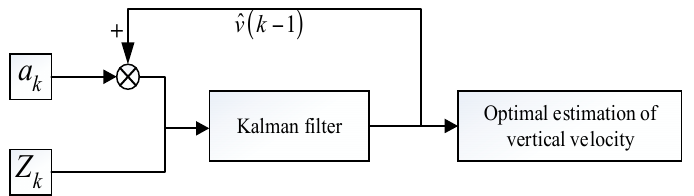
Figure 3. State function of the discretized fusion of the vertical velocity measurements.